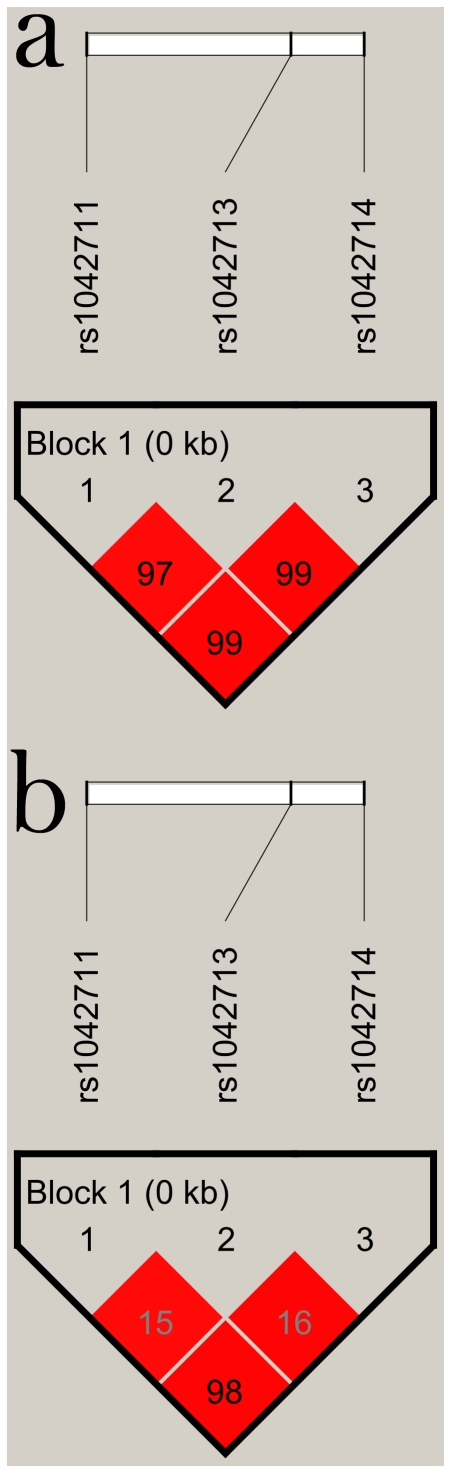
Linkage disequilibrium (LD) block defined by the Haploview program based on the confidence interval method.a represents LD measure of D'. b represents LD measure of r2.